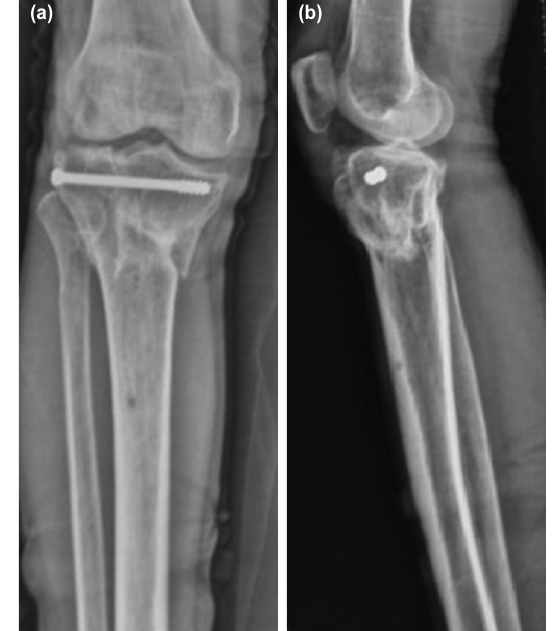
Case No.7, post-operative radiographs. (a) Antero- Fig. 7: posterior view showing olive wore fixation through fibular head for buttressing of latera condyle. (b) Lateral view.